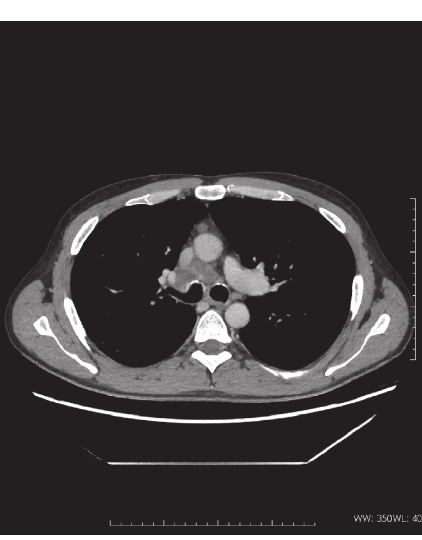
Figure 5: Axial contrast-enhanced CT scan with the presence of enlarged, necrotic mediastinal lymph nodes at the level of carina.